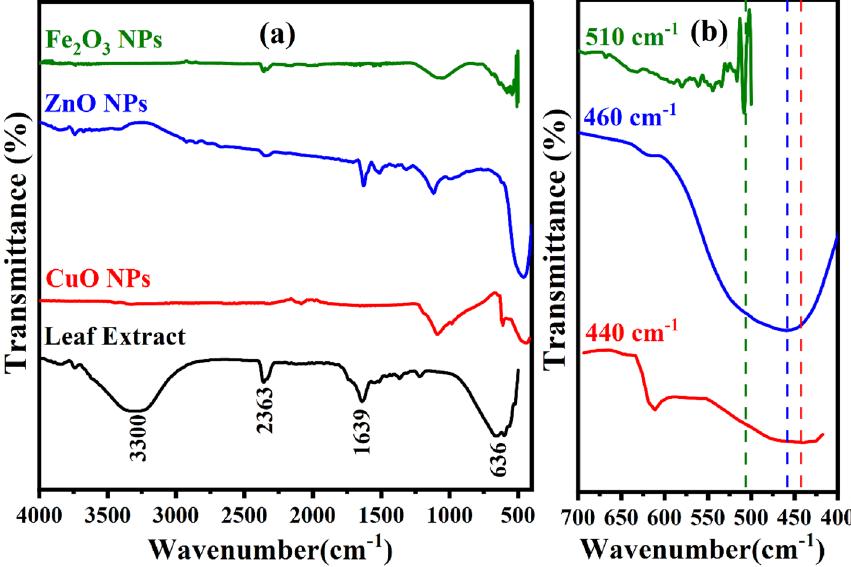
Figure 2. ( a ) FTIR spectra of Portulaca oleracea L. leaf Extract, α-Fe 2 O 3 , CuO, and ZnO NPs; ( b ). Zoomed view range (400 to 700 cm −1 ) of synthesized α-Fe 2 O 3 , CuO, and ZnO